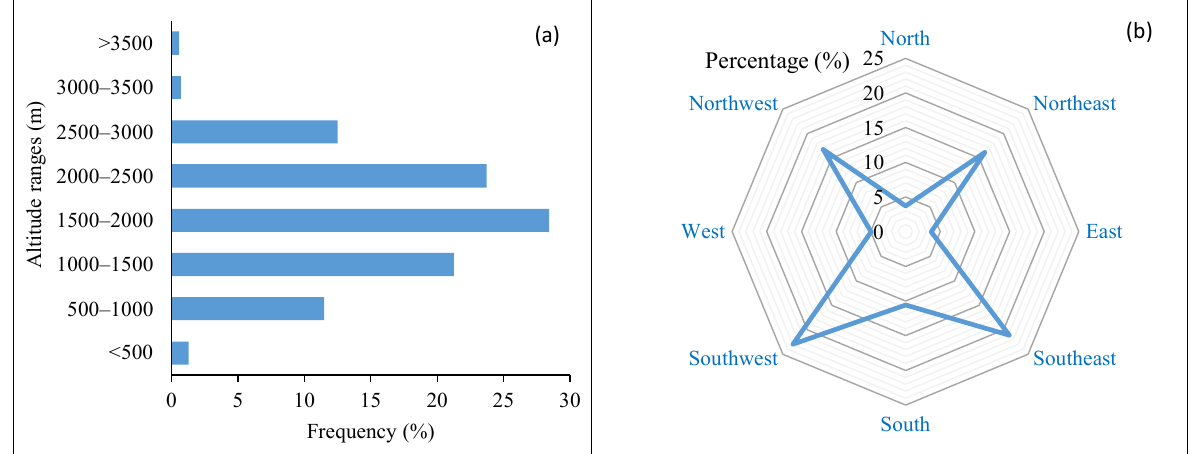
Figure 3. ( a ) Altitude and ( b ) slope aspect distribution patterns of Nepalese alder. Slope aspect may also exert impacts on the distribution of Nepalese alder. Nearly 60% of the sites were distributed in south-facing slopes (Figure 3b), and only 37% of the samples were distributed in north-facing slopes, indicating that the Nepalese alder prefers sunny slope habitats, consistent with its sunward and light-loving characteristics [4]. This is also associated with its distribution in the southern foothills of the Himalayas and the mountainous areas of southwest China, both of which showed the same topographic characteristic of high in the north and low in the